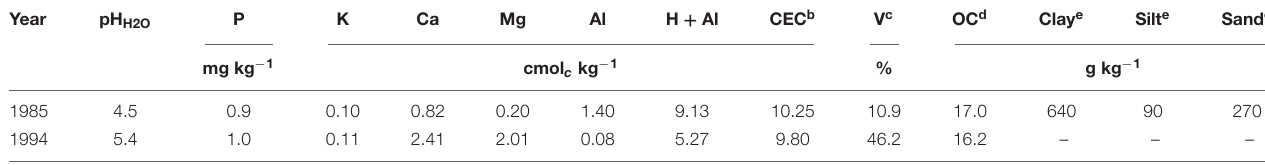
TABLE 1 | Soil chemical parameters a (0–20 cm layer) in two moments prior to the experiment establishment, before and after